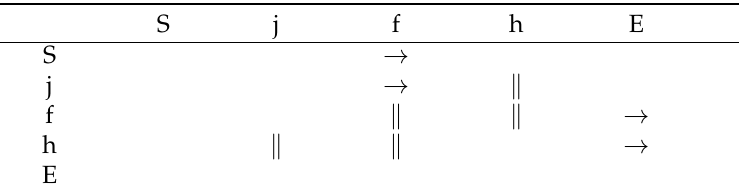
Table 5. Pattern Relation Table T jfh